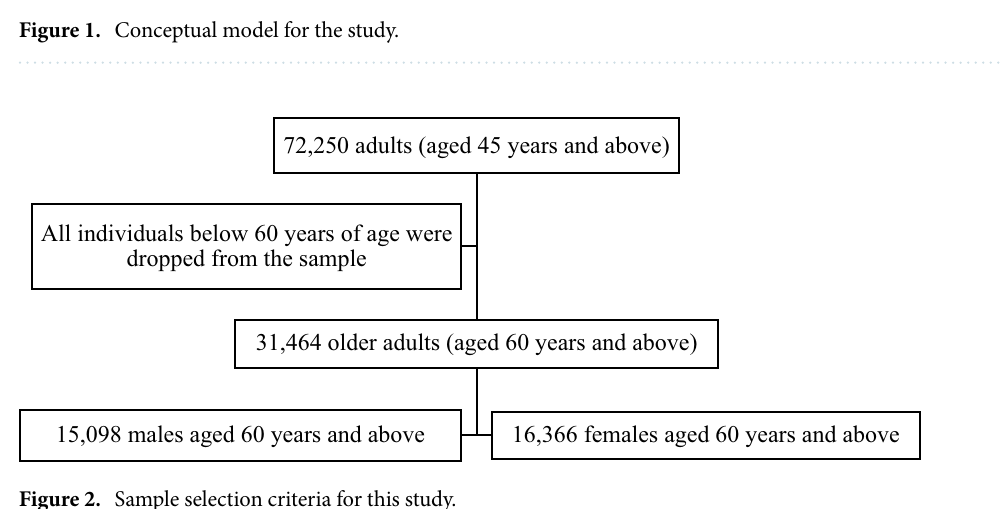
Figure 2. Sample selection criteria for this